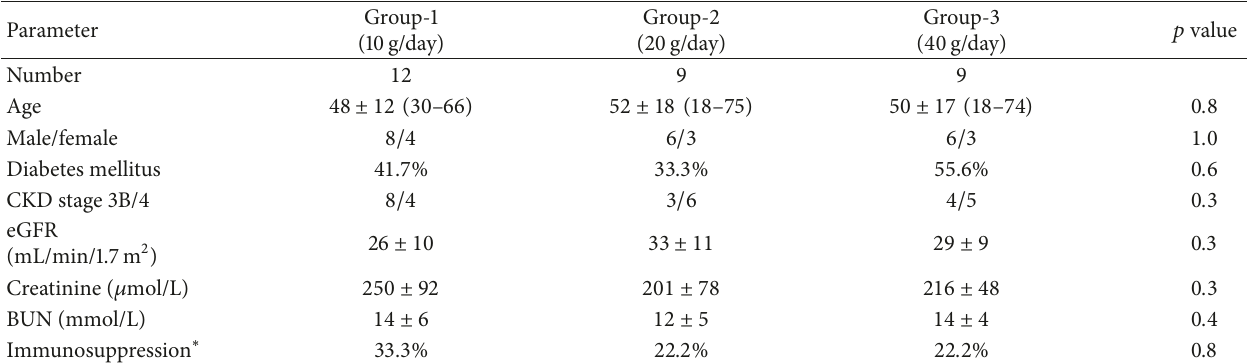
Figure 1: Consort flow diagram of clinical trial patients. Table 1: Baseline characteristics of the study population ( 𝑛 = 30